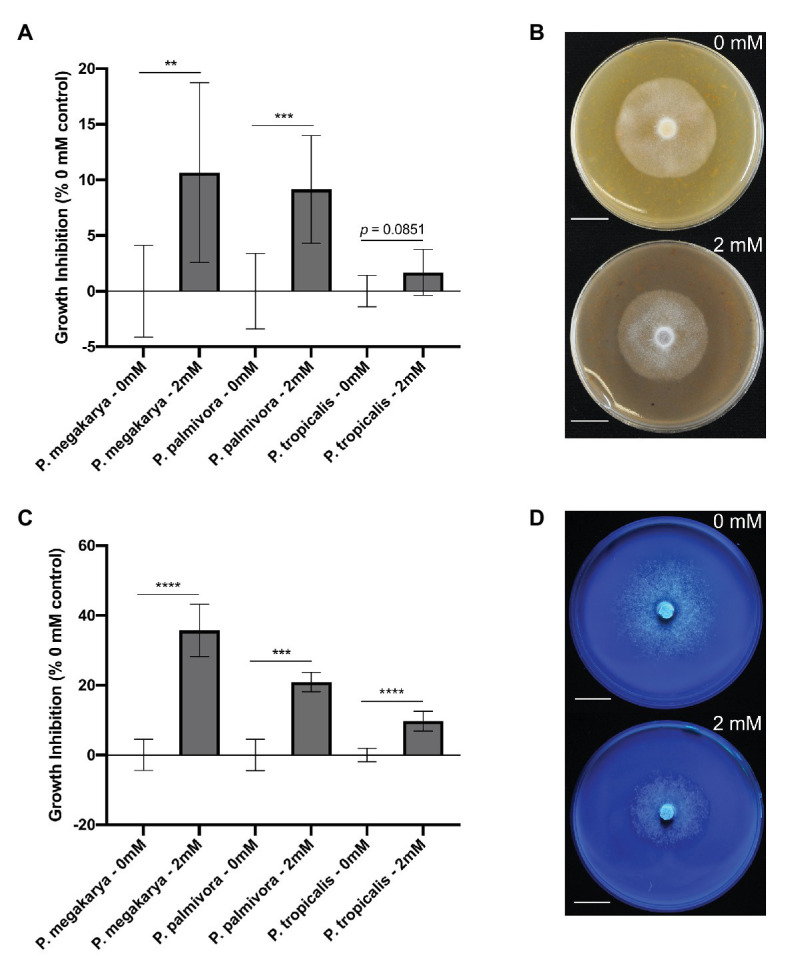

Phytophthora spp. growth inhibition by clovamide. (A) Growth inhibition (%) by clovamide of three Phytophthora species on V8 media. (B) V8 media plates with P. megakarya mycelia with 0 mM clovamide (top) and 2 mM clovamide (bottom). (C) Growth inhibition (%) by clovamide of three Phytophthora species on semi-synthetic Henniger/Casein/Pectin (“HenCasPec”) media. (D) HenCasPec media plates with P. megakarya mycelia with 0 mM clovamide (top) and 2 mM clovamide (bottom), stained with calcofluor and photographed under 365 nm excitation for contrast between white mycelia and white media. Growth inhibition data from two experiments (n = 4 from each), except P. palmivora on HenCasPec, which represents one experiment. p < 0.01 (**), p < 0.001 (***), p < 0.0001 (****), t-test. Error bars in (A) and (C) represent standard deviation.